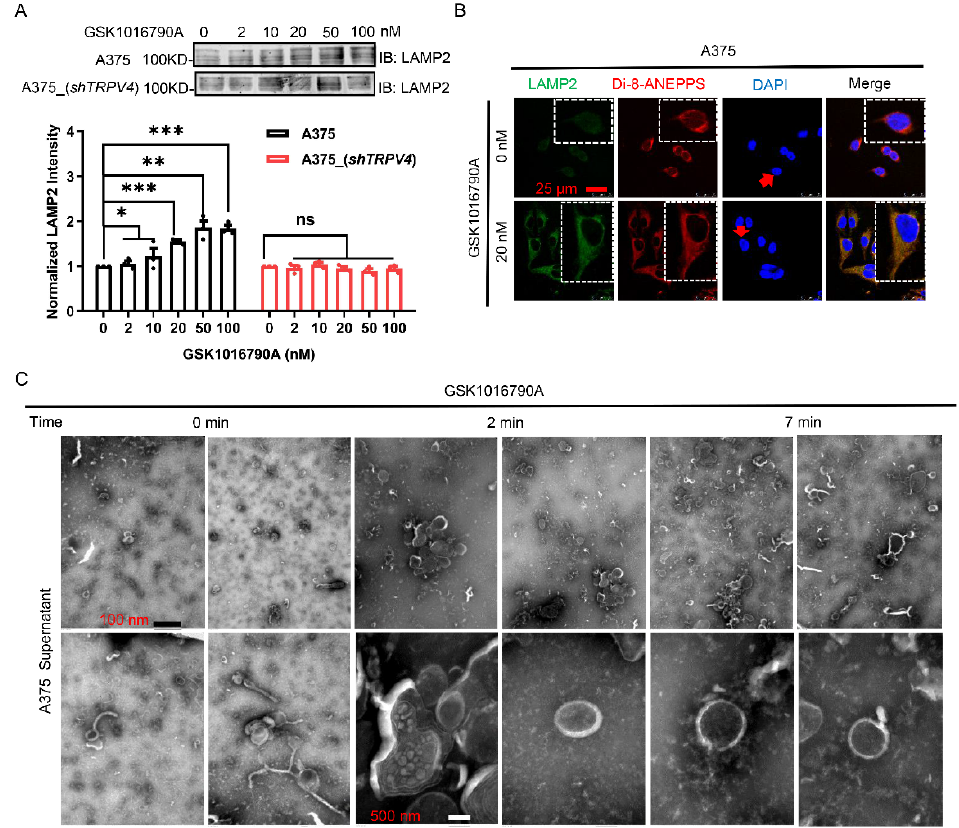
Figure 4. Lysosome-associated protein involves in TRPV4 mediated cell exocytosis. ( A ) Western blot of cell lysates probed for LAMP2 upon GSK1016790A (20 nM) in A375 cell as well as shTRPV4 A375 cells. Target protein quantification was normalized to total protein. ( B ) Confocal microscopy images of A375 cells immunostained for LAMP2. Scale bar, 25 μ m. ( C ) Transmission electron microscopic images of lysosomes in cell supernatant upon GSK1016790A (20 nM) application. Scale bar as indicated in figure. Data are presented as mean ± SD of at least three independent experiments, t -test, * p < 0.05, ** p < 0.01, *** p < 0.001, ns indicates no significance.